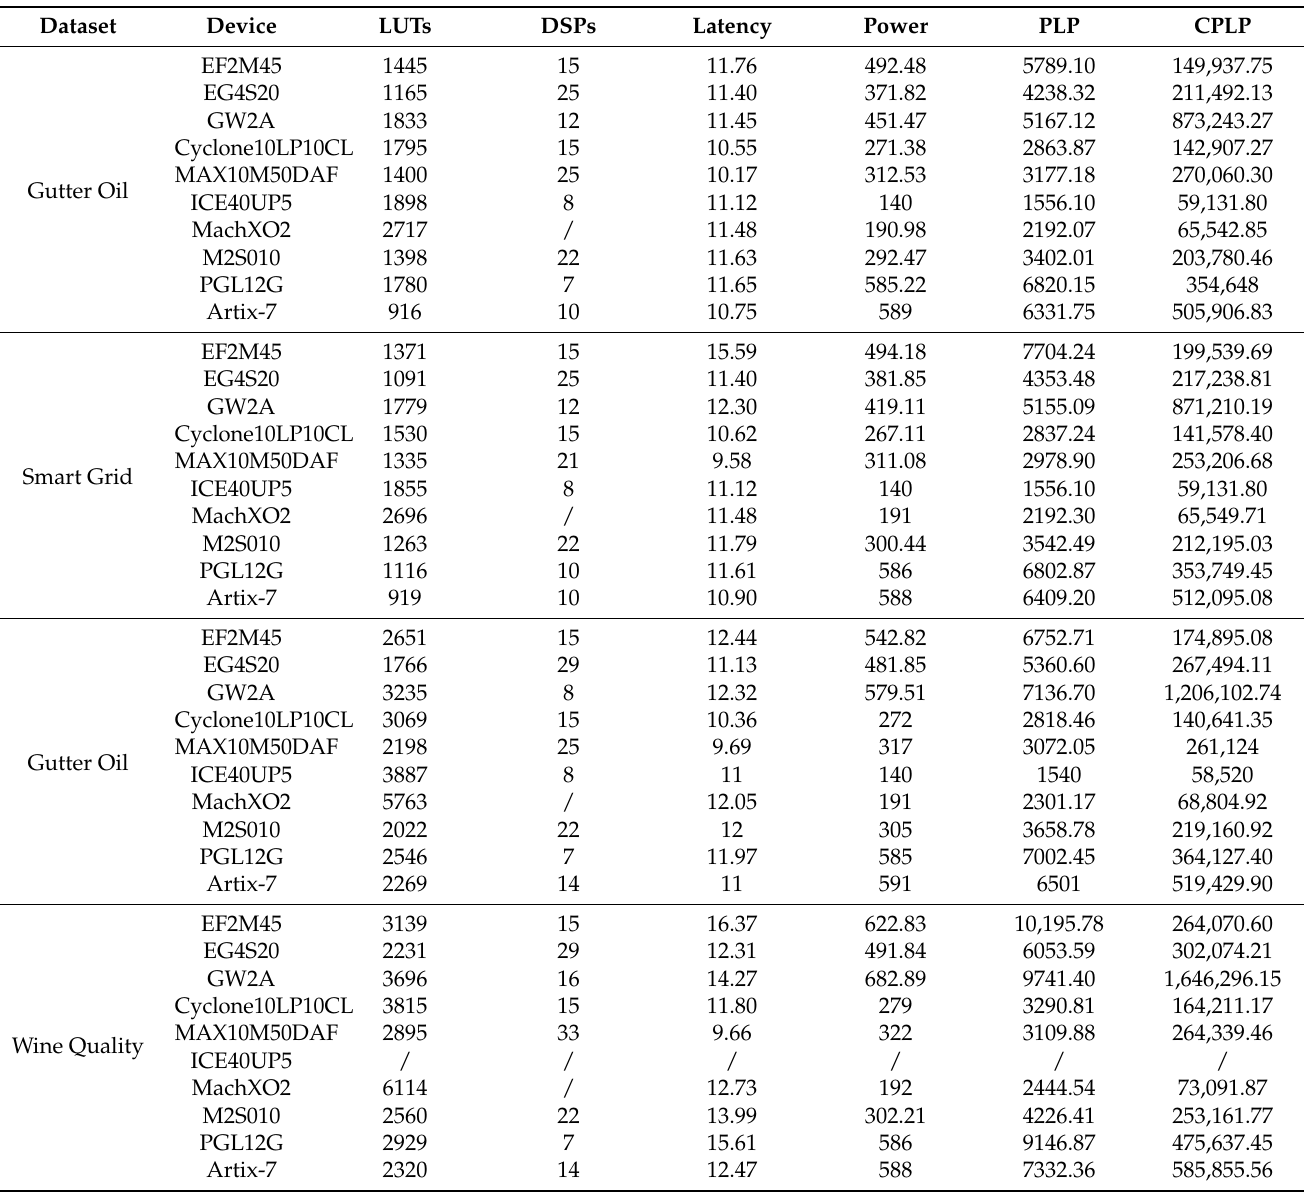
Table A2. ANN deployment results on the low-cost